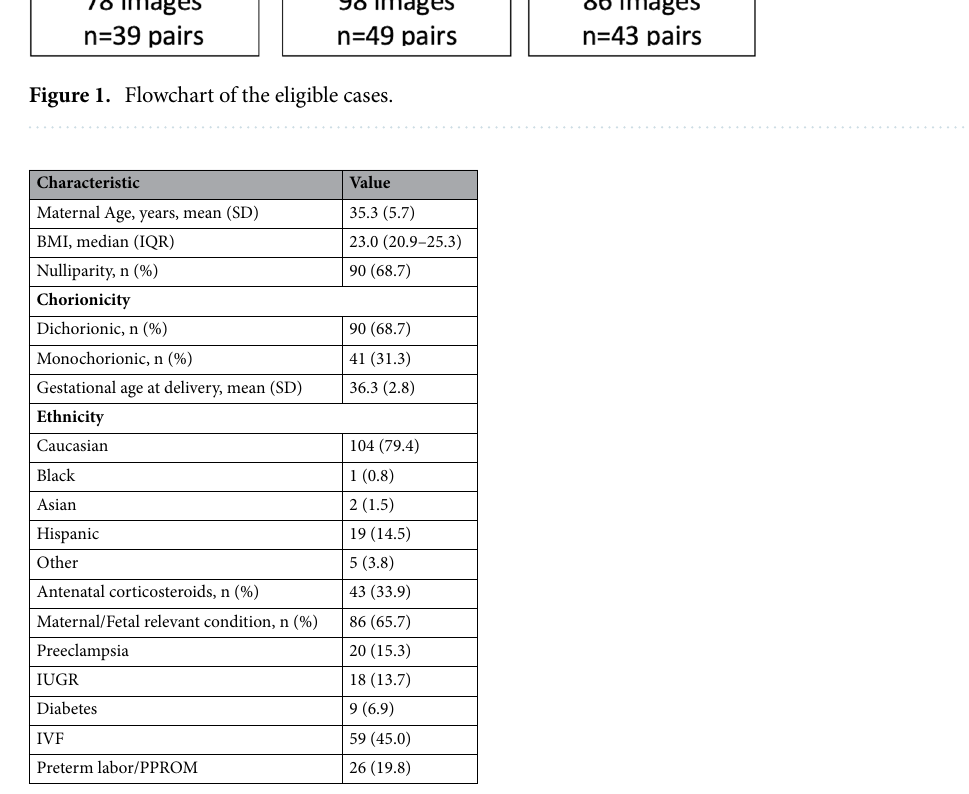
Table 1. Baseline and clinical characteristics of 131 women with twin pregnancy who underwent fetal lung ultrasound examination. Data are presented as mean and standard deviation (SD), percentage